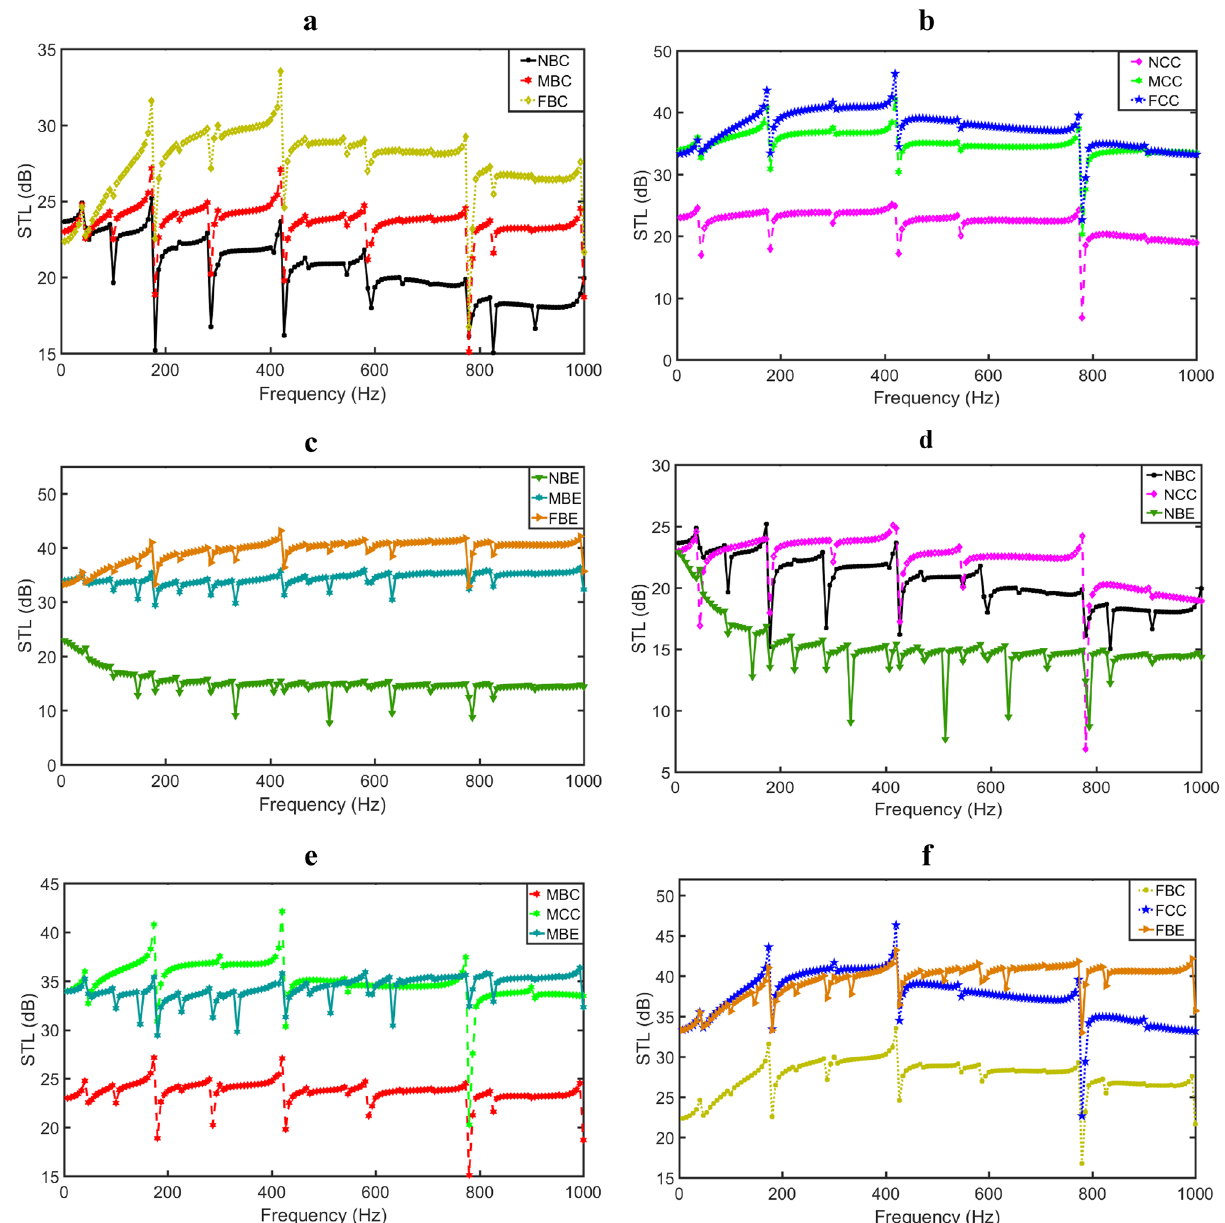
Figure 10. Transmission loss comparison of six location categories of the sound source ( a ) LC1, ( b ) LC2, ( c ) LC3, ( d ) LC4, ( e ) LC5, ( f )